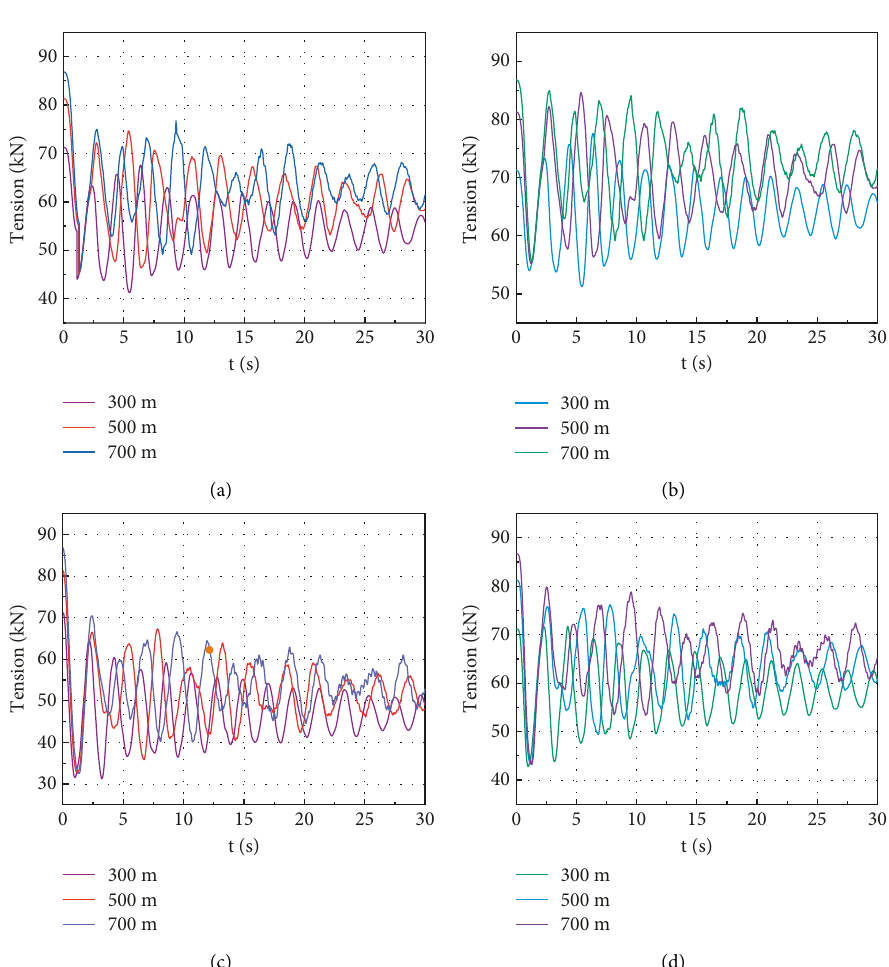
Figure 10: Tension-time curves of subconductor with different span length: (a) A1 conductor (b) A2 conductor (c) A3 conductor (d) A4